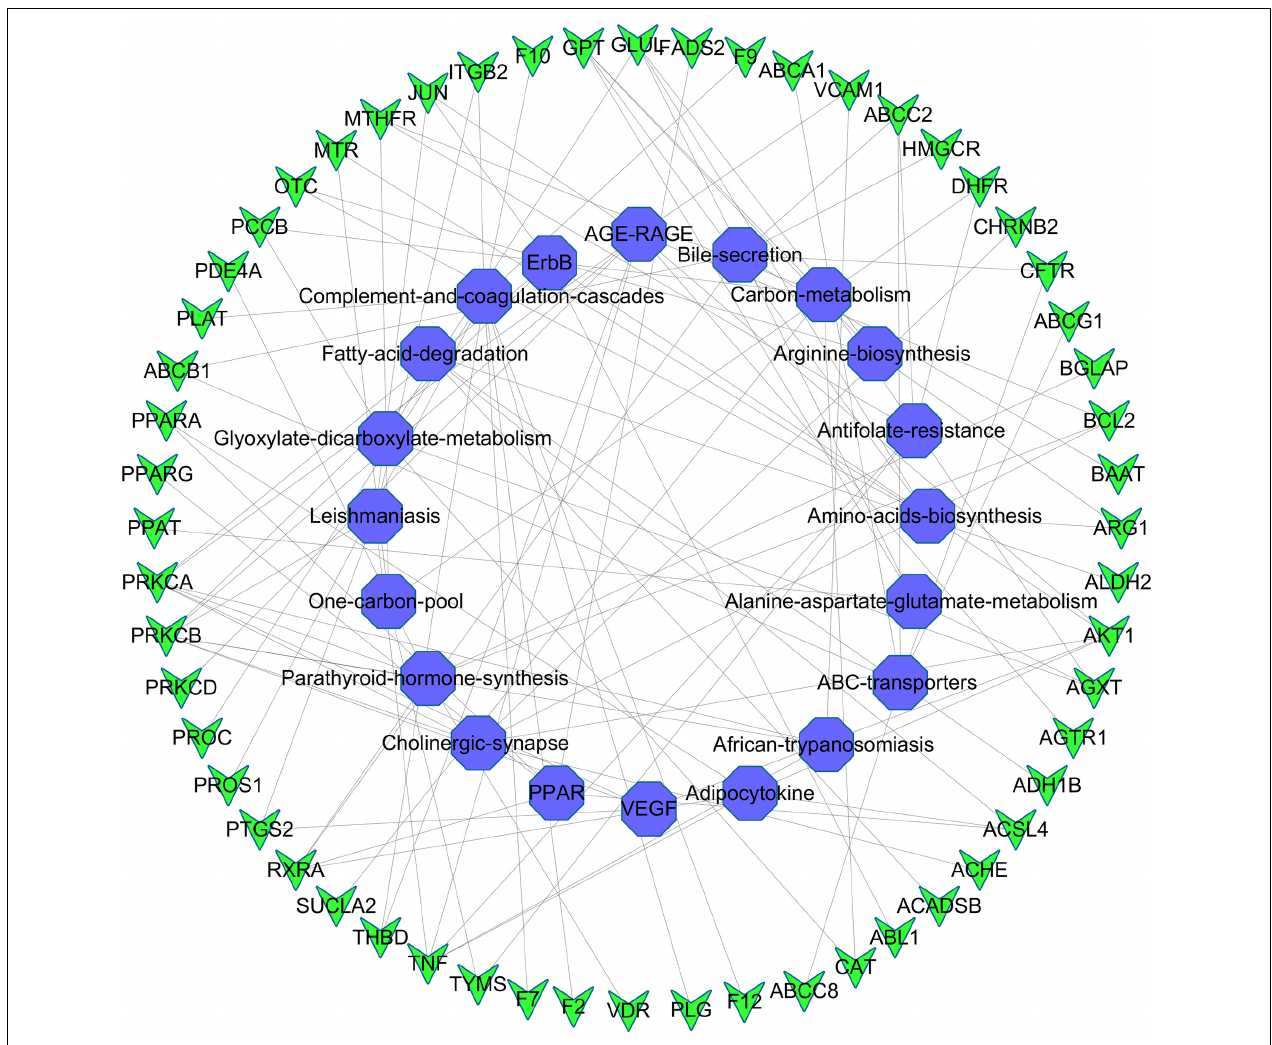
FIGURE 8 | The top 20 pathways and the related gene targets by KEGG analysis. Purple symbols represent pathways and green were gene